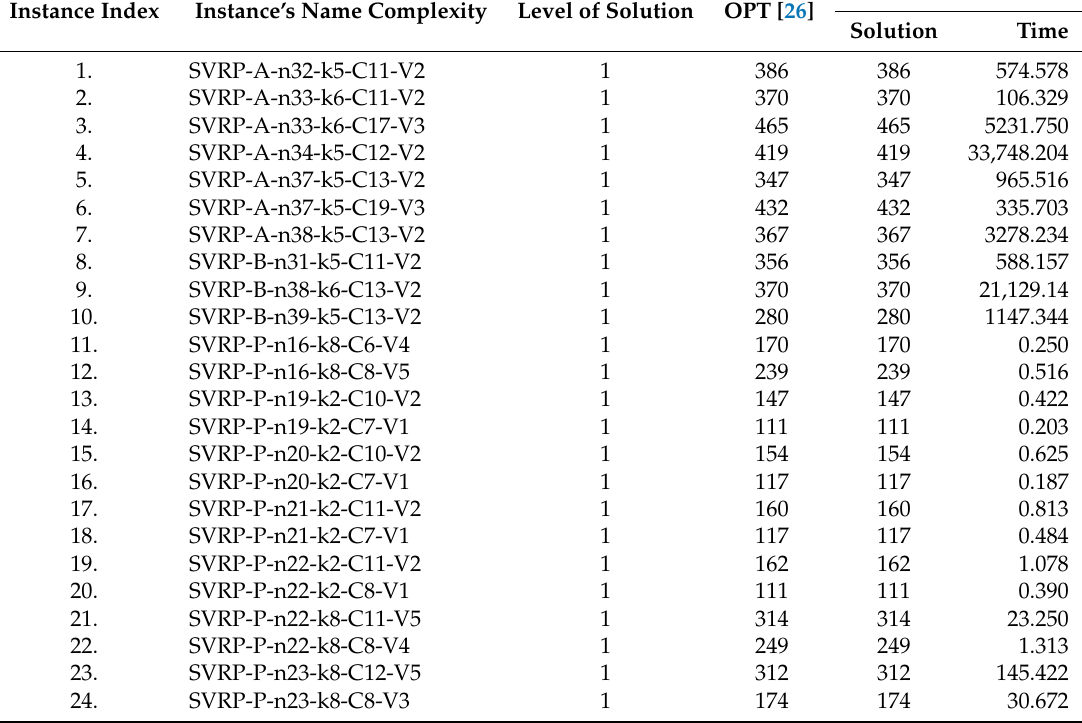
Table 2. Computational results achieved by our mathematical model in the case of SVRP instances with level of complexity